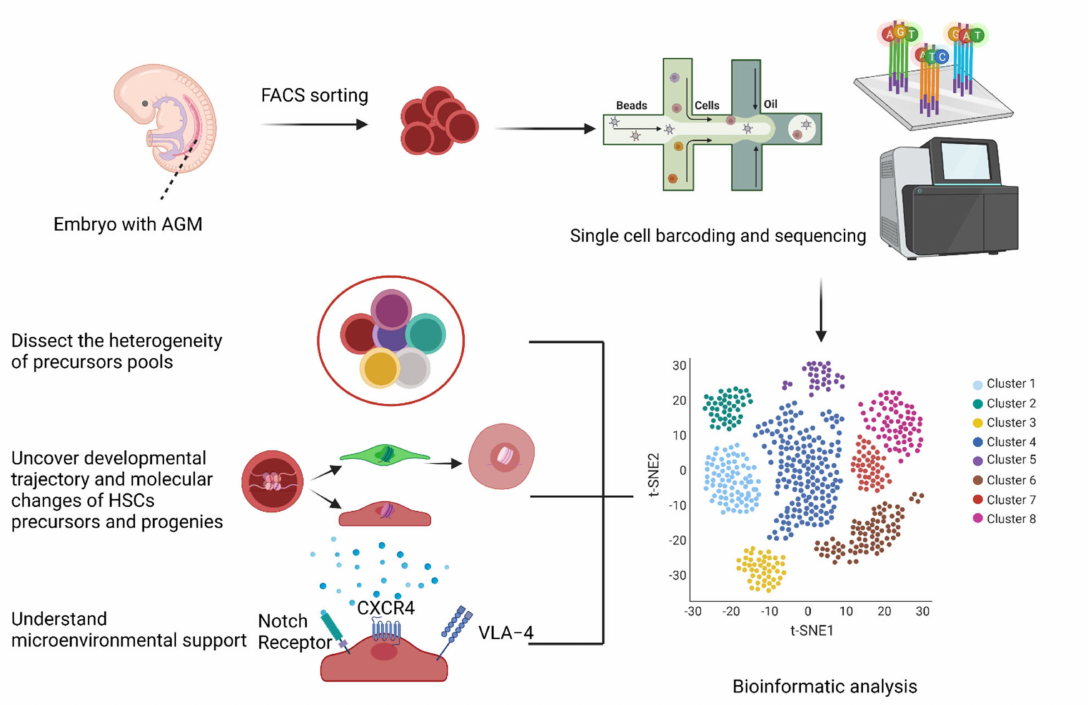
Figure 2. Schematic overview of the application of single-cell RNA-seq in deciphering the complexity of precursors pools, developmental trajectory or molecular changes in HSC pools, and environmental supporting signals. Both the time point of the embryos (E10.5 in mice) and the resolution of transcriptomics hold the key to identifying the crucial factors that define HSCs, such as Notch, CXCR4, and VLA-4. (The figure was created with BioRender.com (accessed on 24